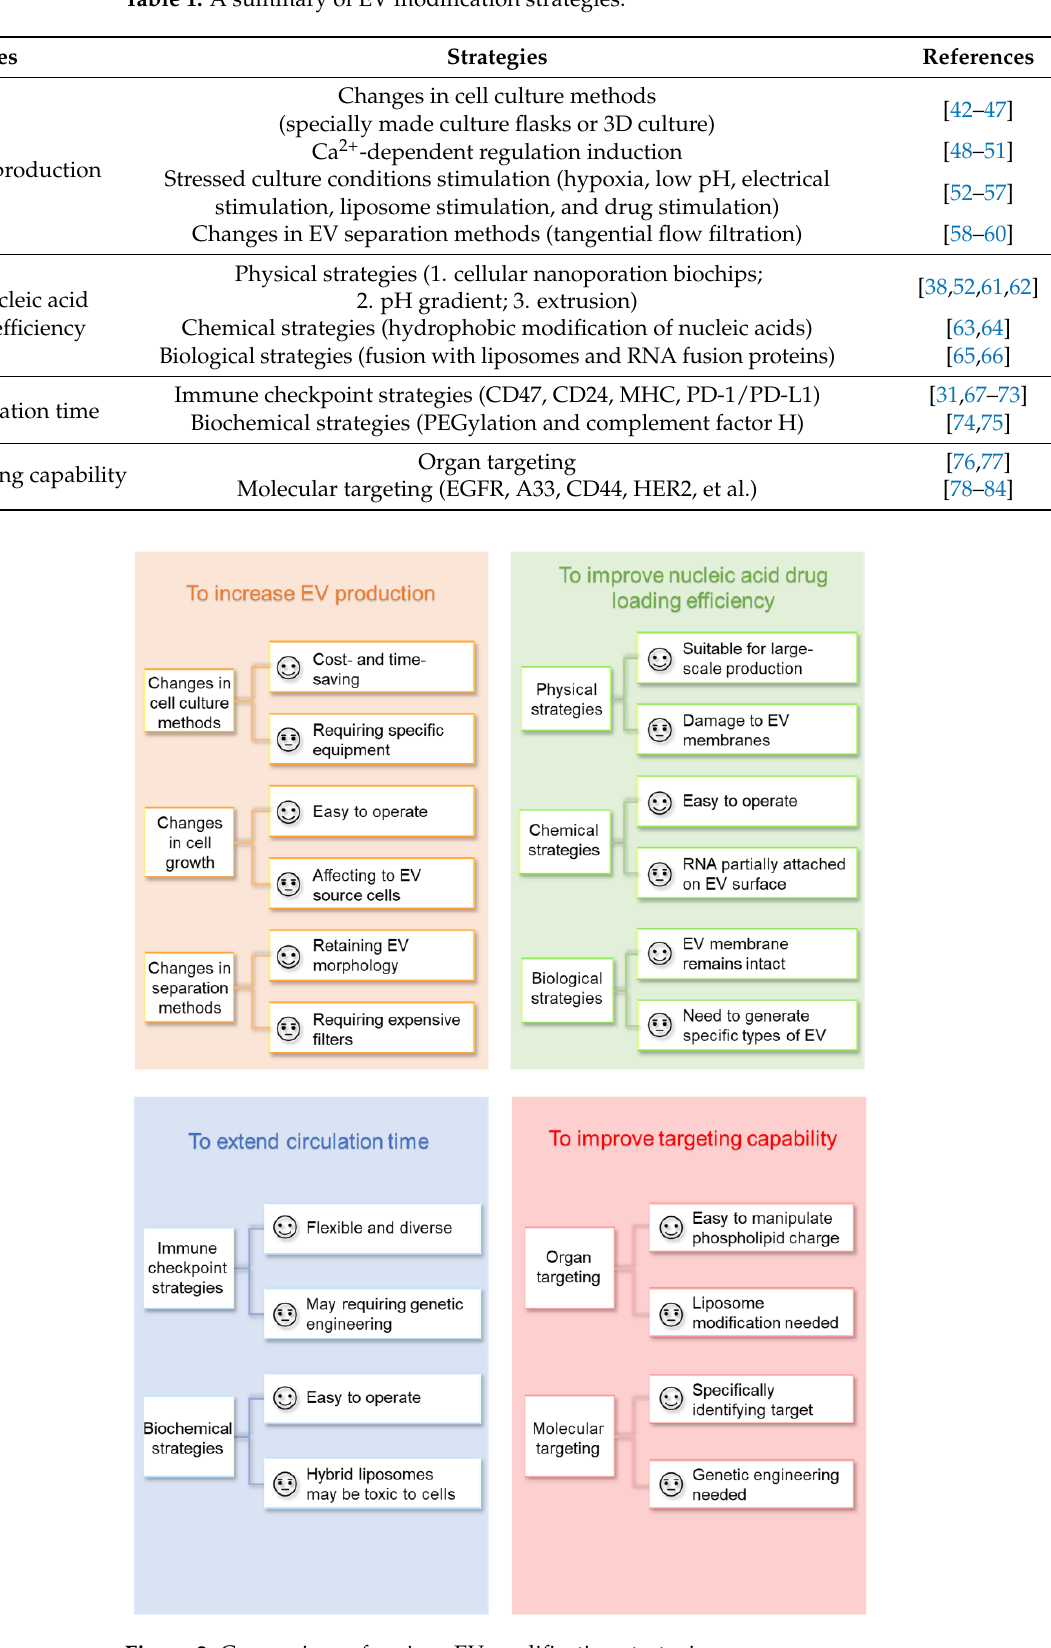
Figure 2. Comparison of various EV modification strategies. Table 1. A summary of EV modification strategies.